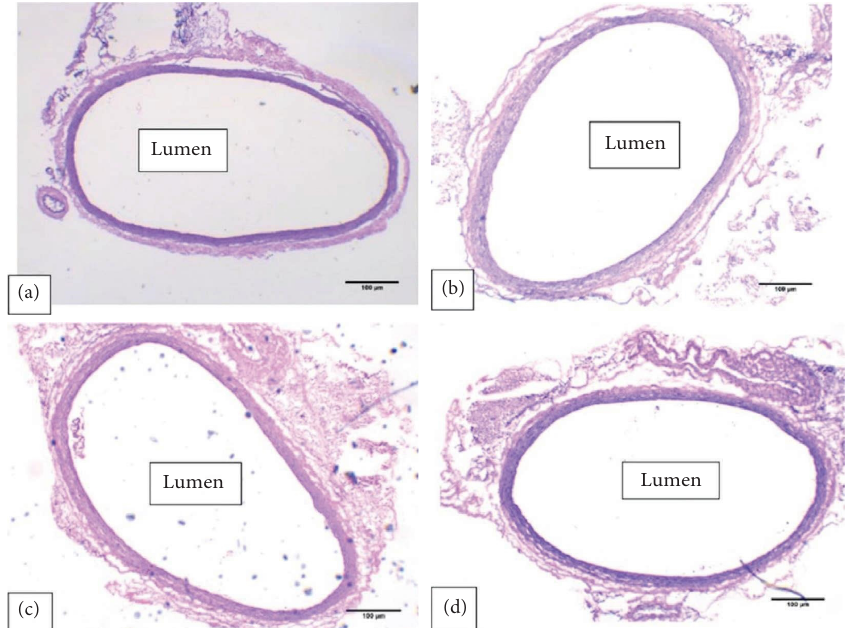
Figure 12: Microscopic view of the aortic lumen stained with hematoxylin-eosin at 40 × magnifcation. An irregularity in the arrangement of the walls was observed in the hyperglycemic control group. (a) Control group. (b) Hyperglycemic control group. (c) Hyperglycemic rats that performed moderate-intensity continuous training (MICT). (d) Hyperglycemic rats that performed high-intensity interval training